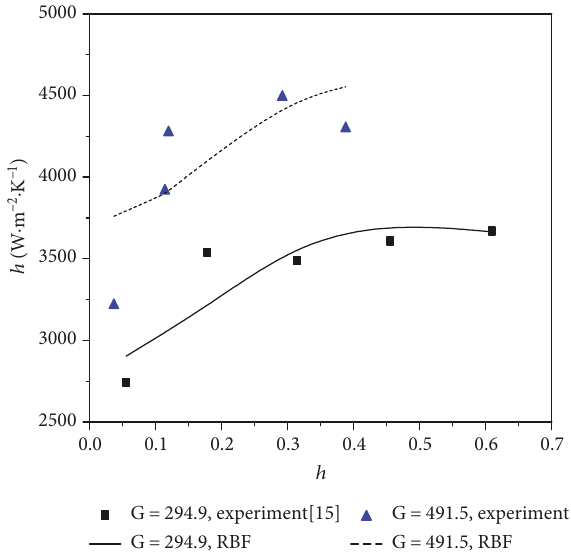
Figure 7: When the evaporation temperature is 60 ° C, the heat transfer coe ffi cient of R245fa changes with dry and mass fl ux